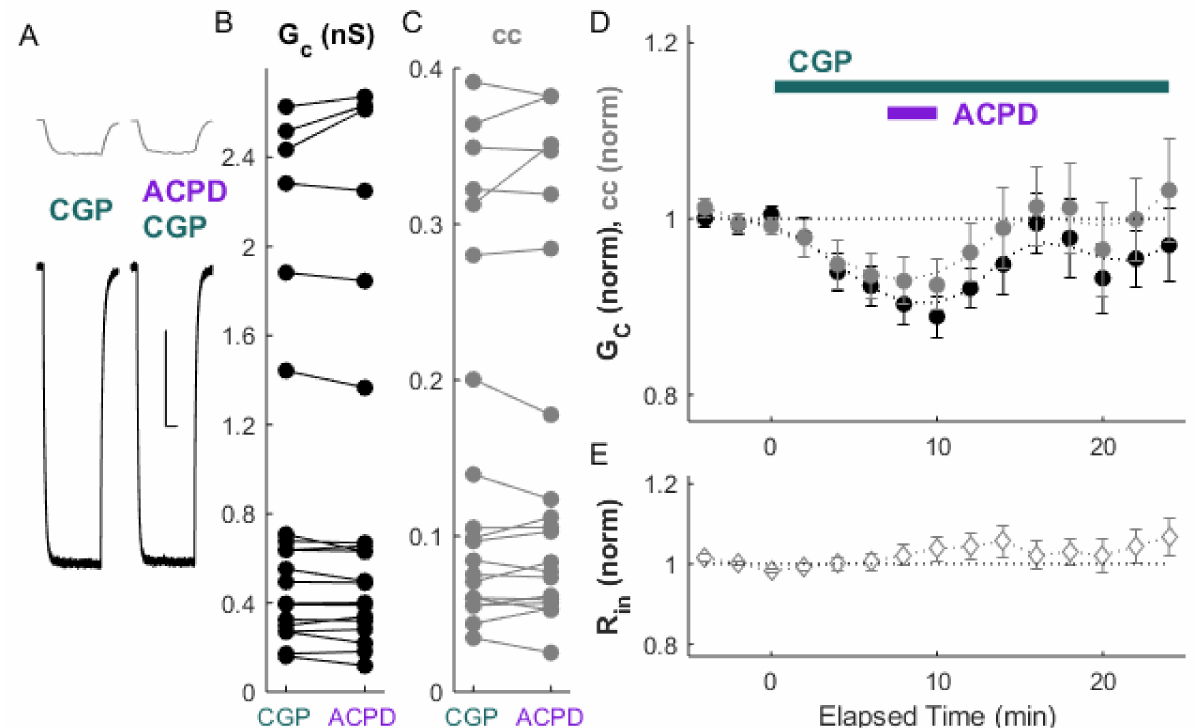
Figure 5. ACPD fails to induce LTD in the presence of the GABA B receptor antagonist CGP. ( A ) Example of paired recordings of electrically coupled neurons, in response to a − 100 pA step to one neuron (bottom trace), before and after bath ACPD application, with CGP in the bath. Scale bar 100 ms, 5 mV for both neurons. ( B ) Conductance G C and ( C ) and coupling coefficients cc for the cohort of pairs used in this experiment. ( D ) After ACPD application (50 µ M), ∆ G C (black) was − 1.5 ± 1.0%, p w = 0.5, and ∆ cc (grey) was 4.2 ± 1.1%, p w = 0.2, relative to values in CGP (between 2 and 7 min) ( n = 20 pairs). ( E ) Input resistance for all neurons over the experiment.